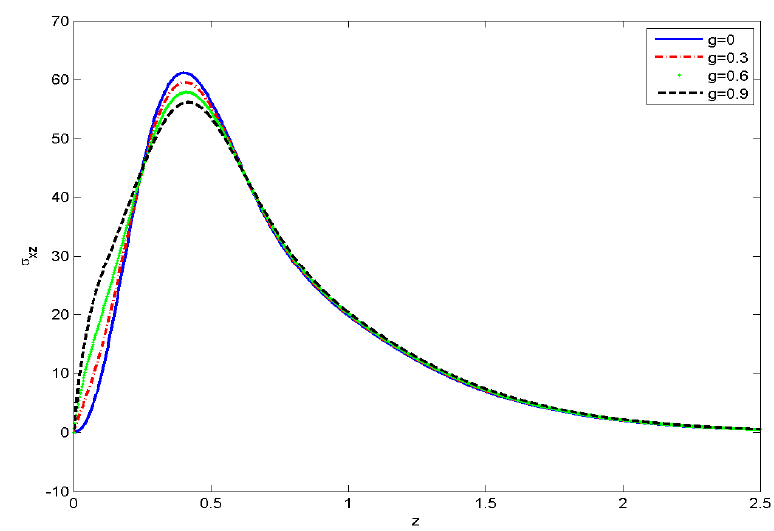
Figure 30. Shear stress σ xz concerning z with gravity g.